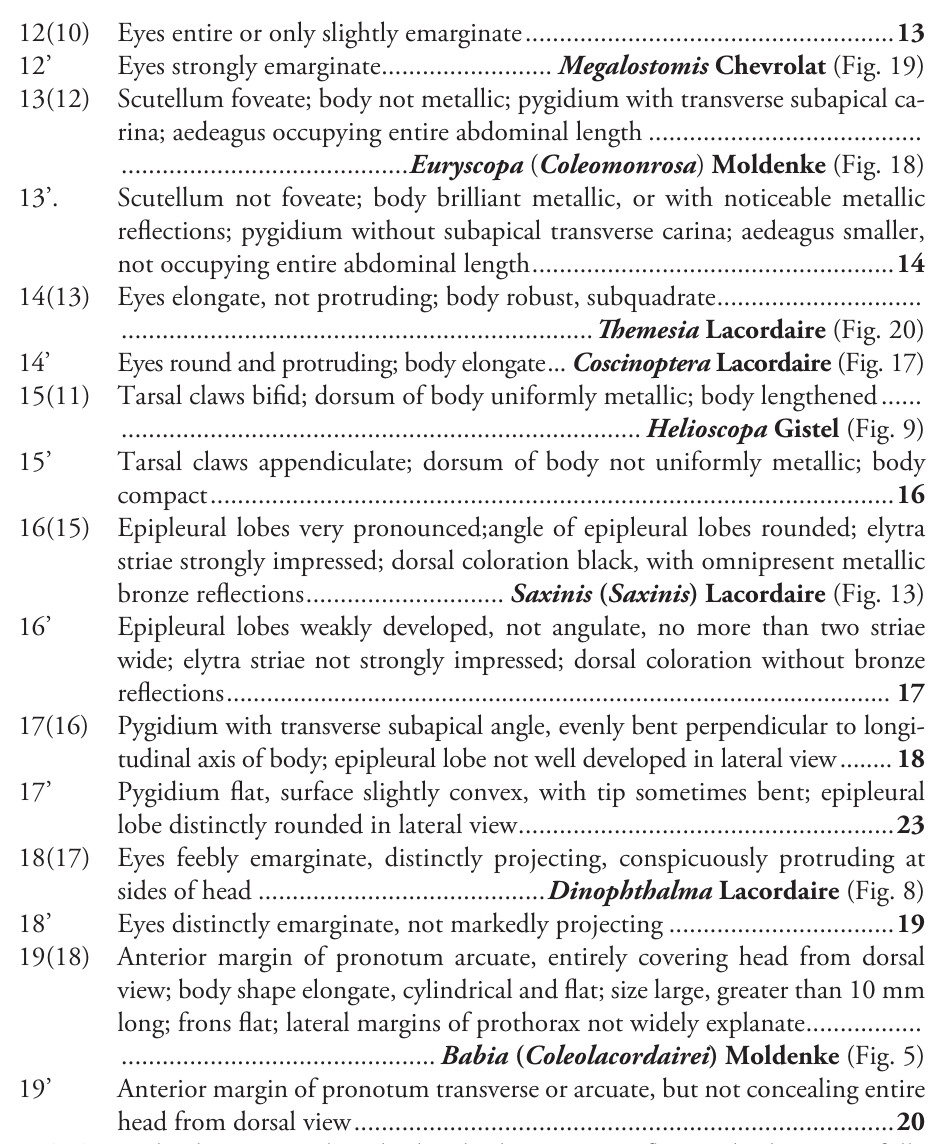
20’ Body shape not cylindrical or elongate; elytra fully covering pygidium; elytral Frons strongly tapering, triangular, without transverse sulcus; body shape subquadrate; aedeagus with strong dorsal and ventral tufts of pubescence ..... 21’ Frons not strongly tapering below eyes, subrectangular, with length only slightly greater than width; aedeagus without pronounced ventral and